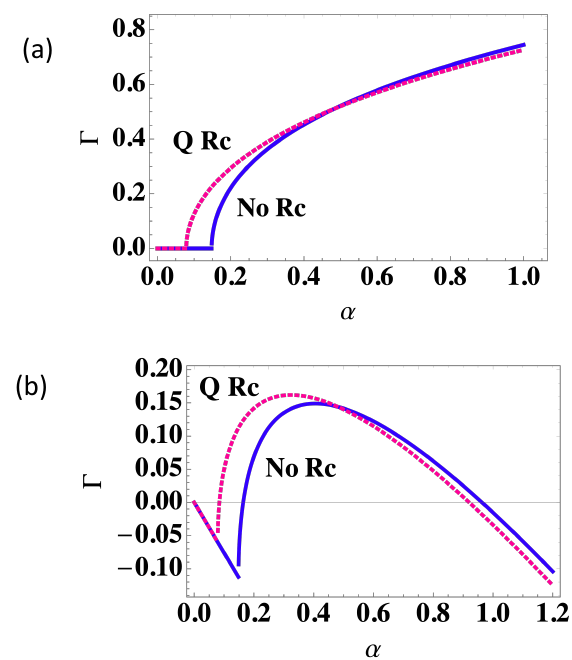
Figure 3. Quantum recoil effects: Damping rate Γ = (cid:61) ( Ω ) with quantum recoil (Q Rc), as compared with and quasi-classical damping rate with no quantum recoil (no Rc), as a function of the collective coupling parameter α , for a finite detuning, δ = 1: ( a ) for a cold atomic sample, P T = 0; and ( b ) for a thermal sample, P T =